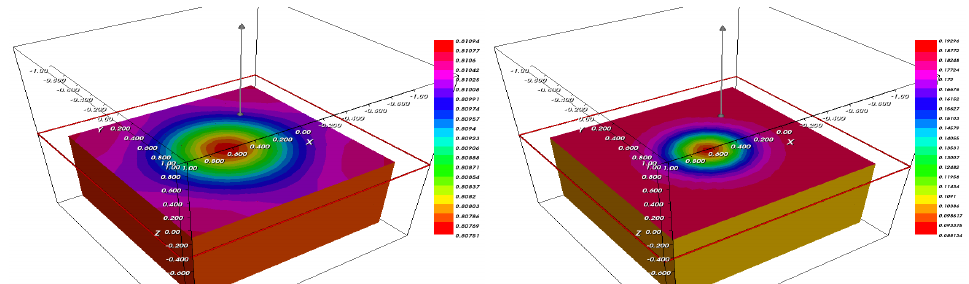
Figure 17. The fraction ϕ ( left ) and ψ ( right ) after T =